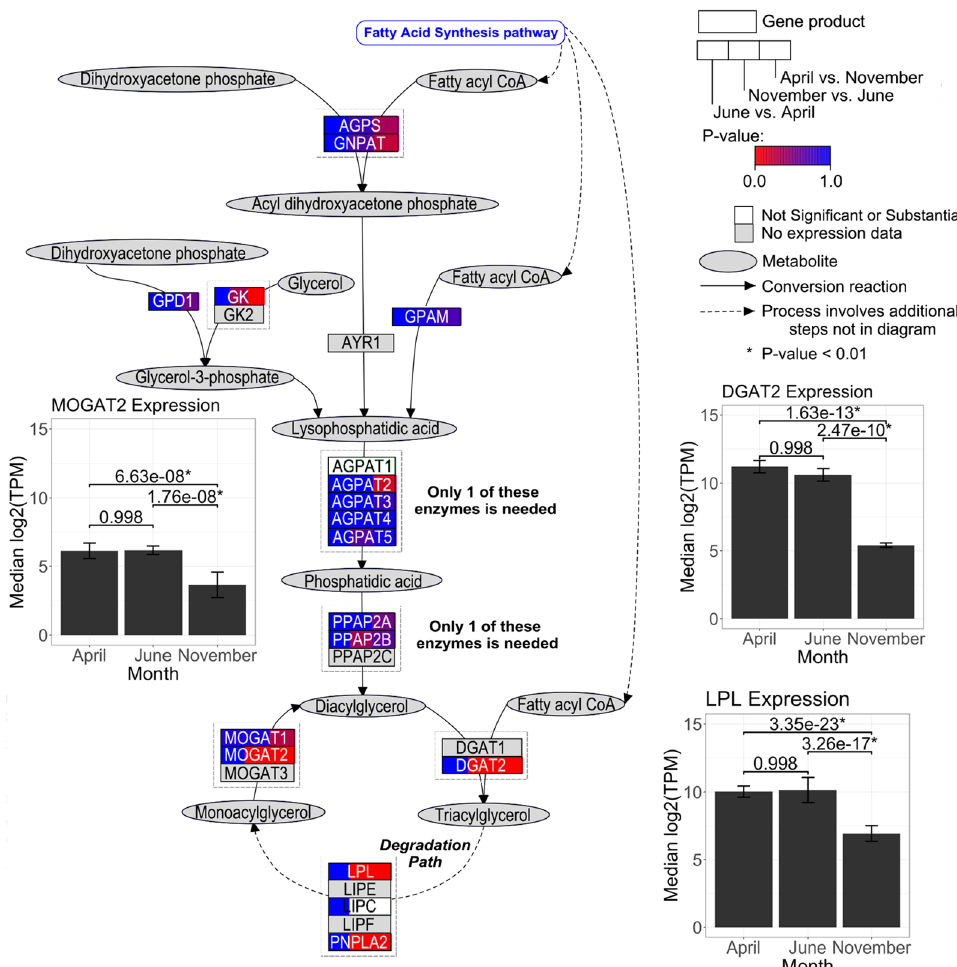
Figure 4. Triacylglycerol synthesis pathway for female seasonal differential expression. Emu triacylglycerol synthesis is represented by the Gallus gallus pathway, which is fuelled by the fatty acid synthesis pathway to provide fatty acyl-CoA metabolites. Metabolites (grey oval nodes) are catalysed (black solid arrows) by gene products (rectangle nodes). Dashed arrows represent a process that involves additional steps not displayed in the diagram. Gene products are split into thirds and correspond to the month-wise comparisons from the female seasonal differential expression analysis. Each third is coloured by their respective gene’s Benjamini–Hochberg corrected p-value in a gradient from more significant (red) to less significant (blue). White represents genes that have non-substantial p-values calculated by DESeq2 21 , while grey represents no annotation available for emu or chicken. Three seasonally DE genes ( DGAT2 , LPL , and MOGAT2 ) have bar plots of expression levels in median log 2 (TPM) by month featuring median absolute deviation error bars. Numerical Benjamini–Hochberg corrected p-values are shown above the horizontal brackets of the bars that indicate the month-wise comparison, where an asterisk to the right represents statistical significance (p <